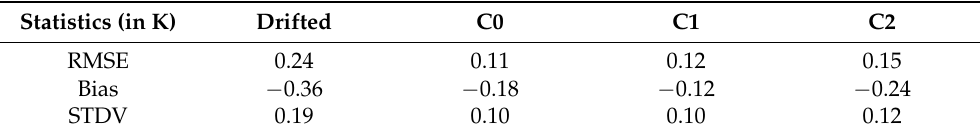
Figure 10. Percentage of cloud-free data averaged over each BELMANIP site. Table 4. Correlations between retrieved statistics and the percentage of cloud-free data for all NOAA platforms and BELMANIP sites for drifted and corrected time series (C0, C1, and